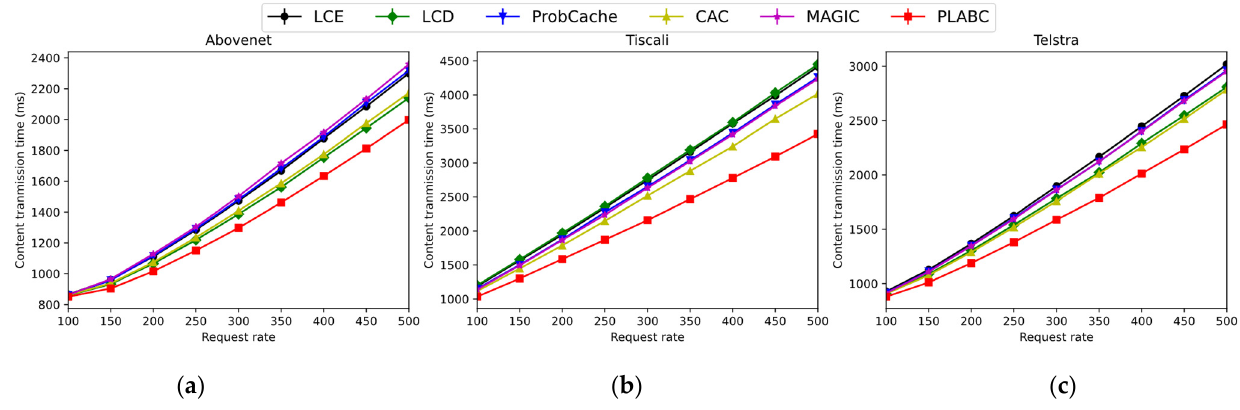
Figure 21. Average content transmission time results of different caching strategies when the total request rate varies under topology: ( a ) Abovenet; ( b ) Tiscali; ( c ) Telstra.